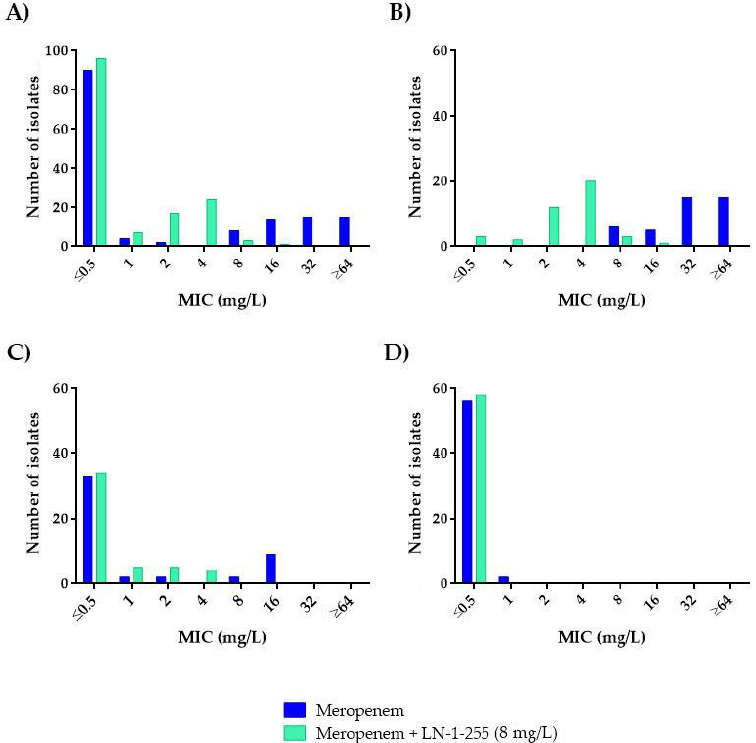
Figure 3. Comparative analysis of meropenem and meropenem/LN-1-255 MICs (mg/L): ( A ) All isolates ( n = 148), ( B ) CHDL-producing A. baumannii ( n = 41), ( C ) A. baumannii producing only OXA-51-like ( n = 48), and ( D ) non- A. baumannii ( n = 59).